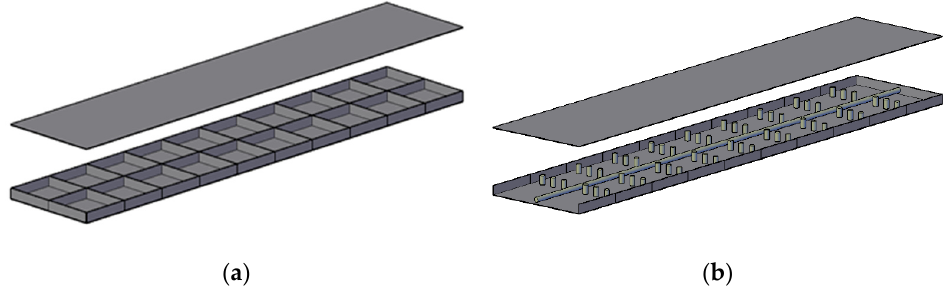
Figure 2. Goland wings ( a ) original Goland wing structures ( b ) a new concept of aircraft wing struc- tures. Table 1. Material properties of aluminum. Table 1. Material properties of aluminum. Properties